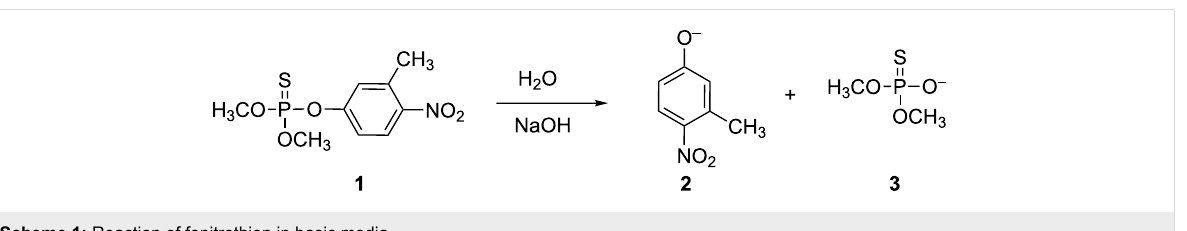
Scheme 1: Reaction of fenitrothion in basic media.